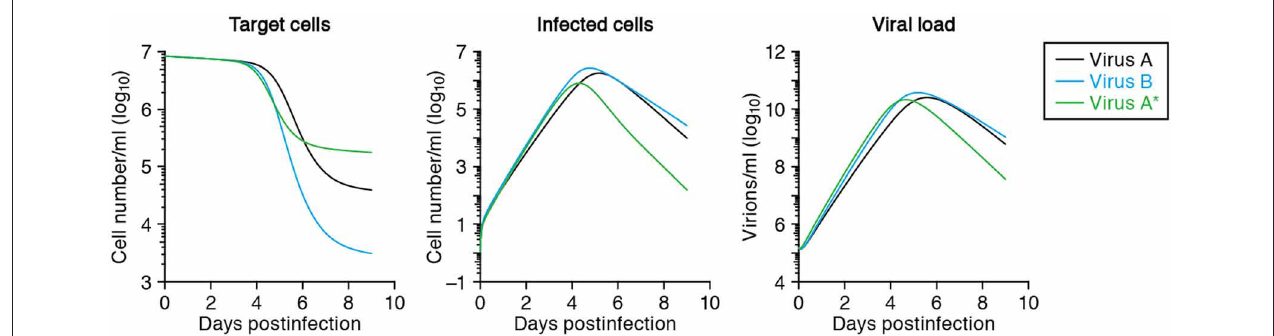
FIGURE 4 | Predicted virus infection kinetics with different parameters. The solid curves show the predicted kinetics of target cells (left), infected cells (middle) and virus load (right) following infection with SHIV-KS661 at an MOI 2 × 10 − 4 using the parameters in Tables 2 and 3 . The time t = 0 corresponds to 24h after inoculation of SHIV-KS661 to HSC-F. In the text we call this virus-A. The dashed and dotted curves show those of the variants